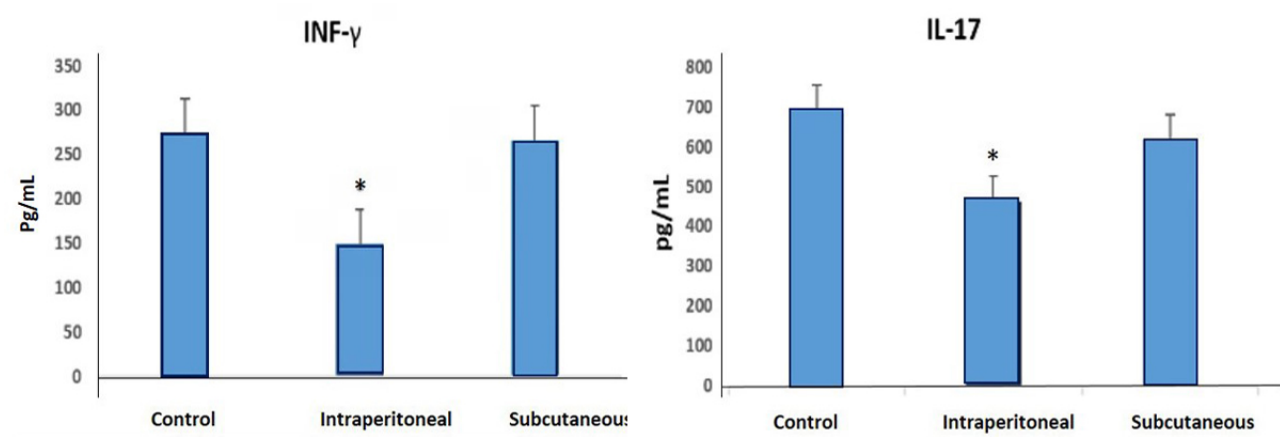
Figure 3. Levels of IFN-γ and IL-17 in different rat groups, namely, control, intraperitoneal SAV-injected and subcutaneous SAV-injected rats.